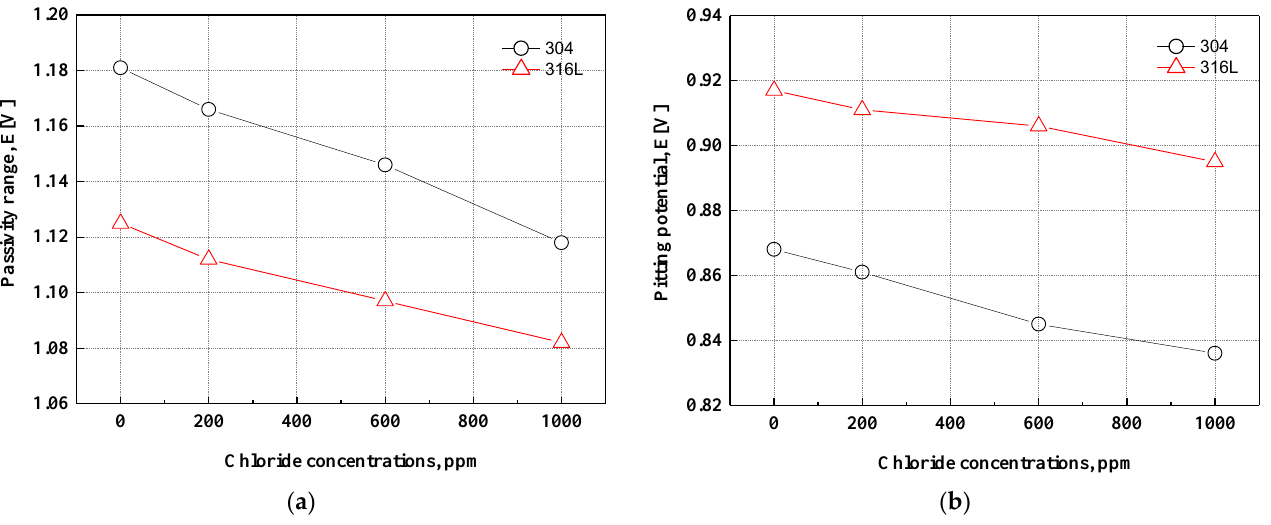
Figure 4. Passivity range and pitting potential for 304 and 316L stainless steels after a potentiody- namic polarization experiment: ( a ) passivity range; ( b ) pitting potential.